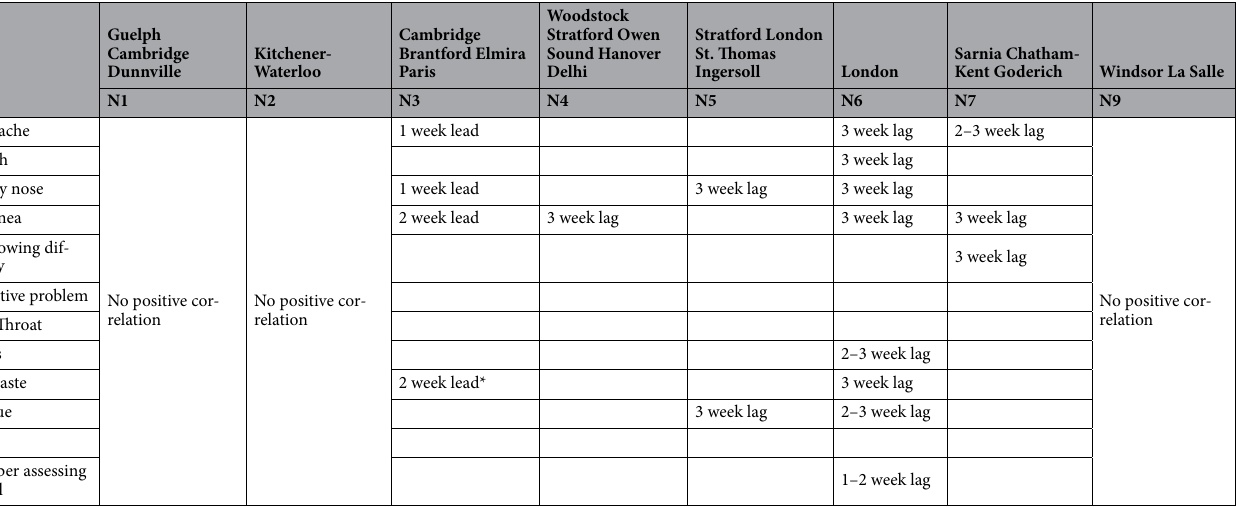
Table 1. Lead-Lag correlation matrix symptoms reported on the portal vs actual COVID-19 cases (per 1000 population) per